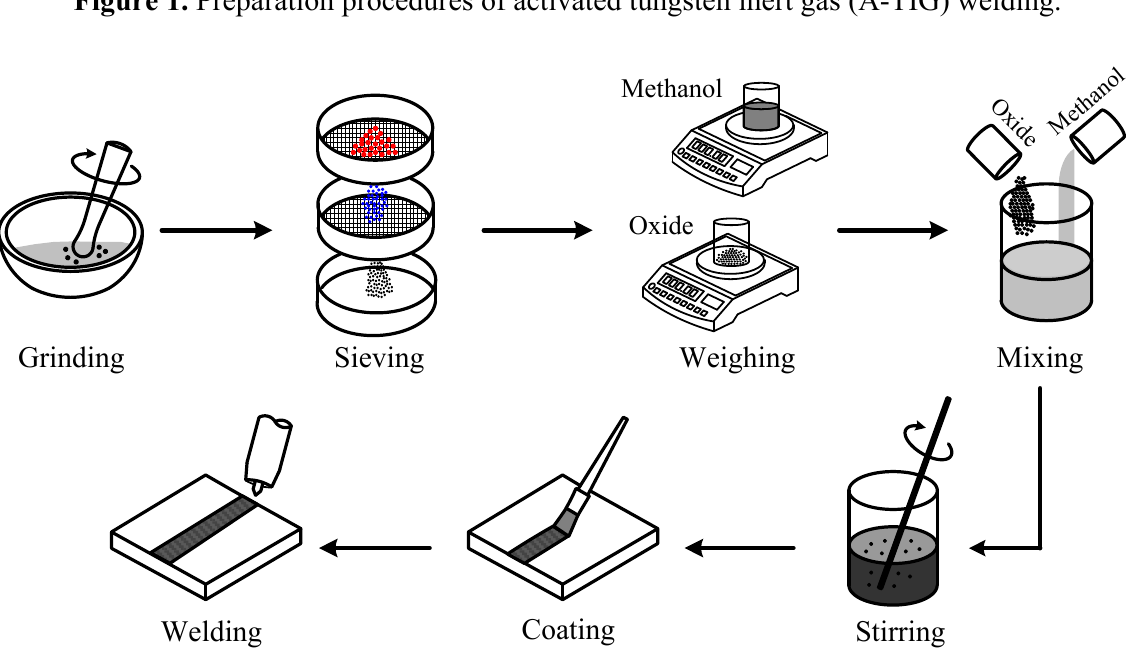
Figure 1. Preparation procedures of activated tungsten inert gas (A-TIG)